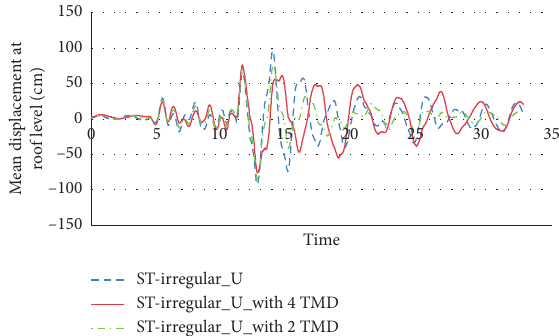
Figure 33: Displacement of the twenty-story irregular U-shaped model with 2 and 4